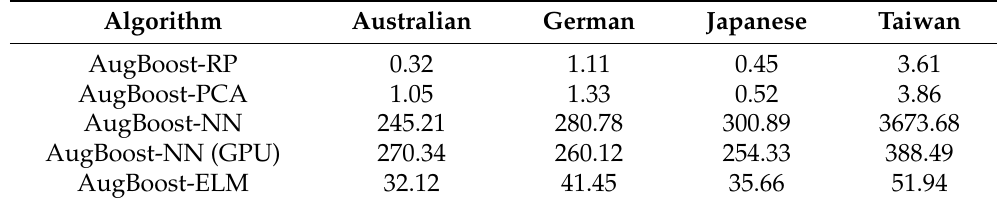
Table 9. Training cost of various AugBoost-based models on the four credit datasets: all the training costs are averaged over 50 times 10-fold cross-validation, the unit of training cost is second, all the results are run on the experimental environment of CPU Intel 9700K with RAM 32 GB and GPU 1080Ti; our implementation is based on python 3.5, gradient boosting framework are realized based on Scikit-learn 0.19.1, AugBoost-NN (GPU) is accelerated by a 1080Ti GPU, which is implemented and tested in Keras with Tensorflow